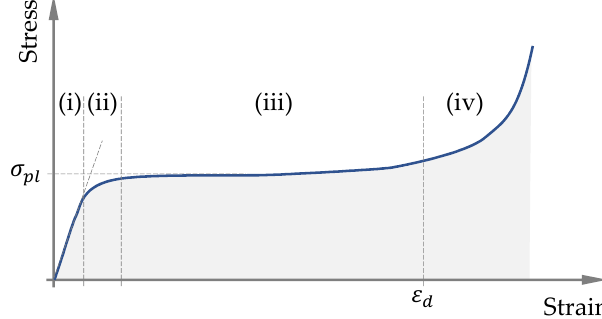
Figure 7. Characteristic compressive behavior of cellular materials.